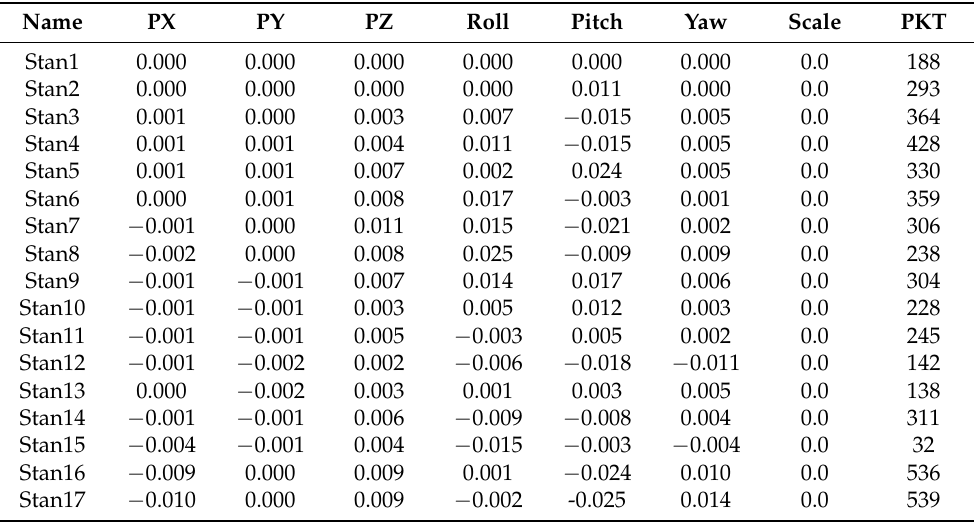
Table 3. Station transformation parameters during stocktaking work involving a steel engineer- ing